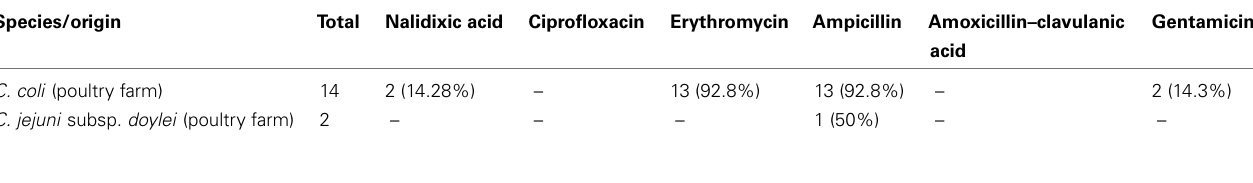
Table 4 |Antimicrobial resistance rates of Campylobacter spp. isolated from poultry and other animal sources in relation to species and sample